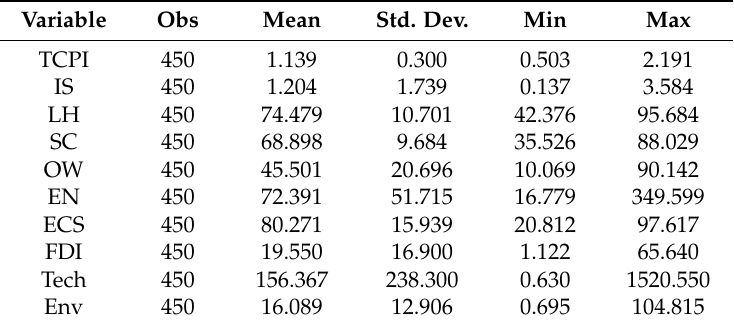
Table 2. Descriptive statistics of panel